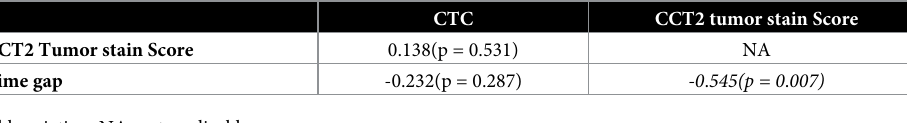
Table 2. Spearman correlation for CCT2 tumor stain score, circulating tumor cell (CTC) count, and time